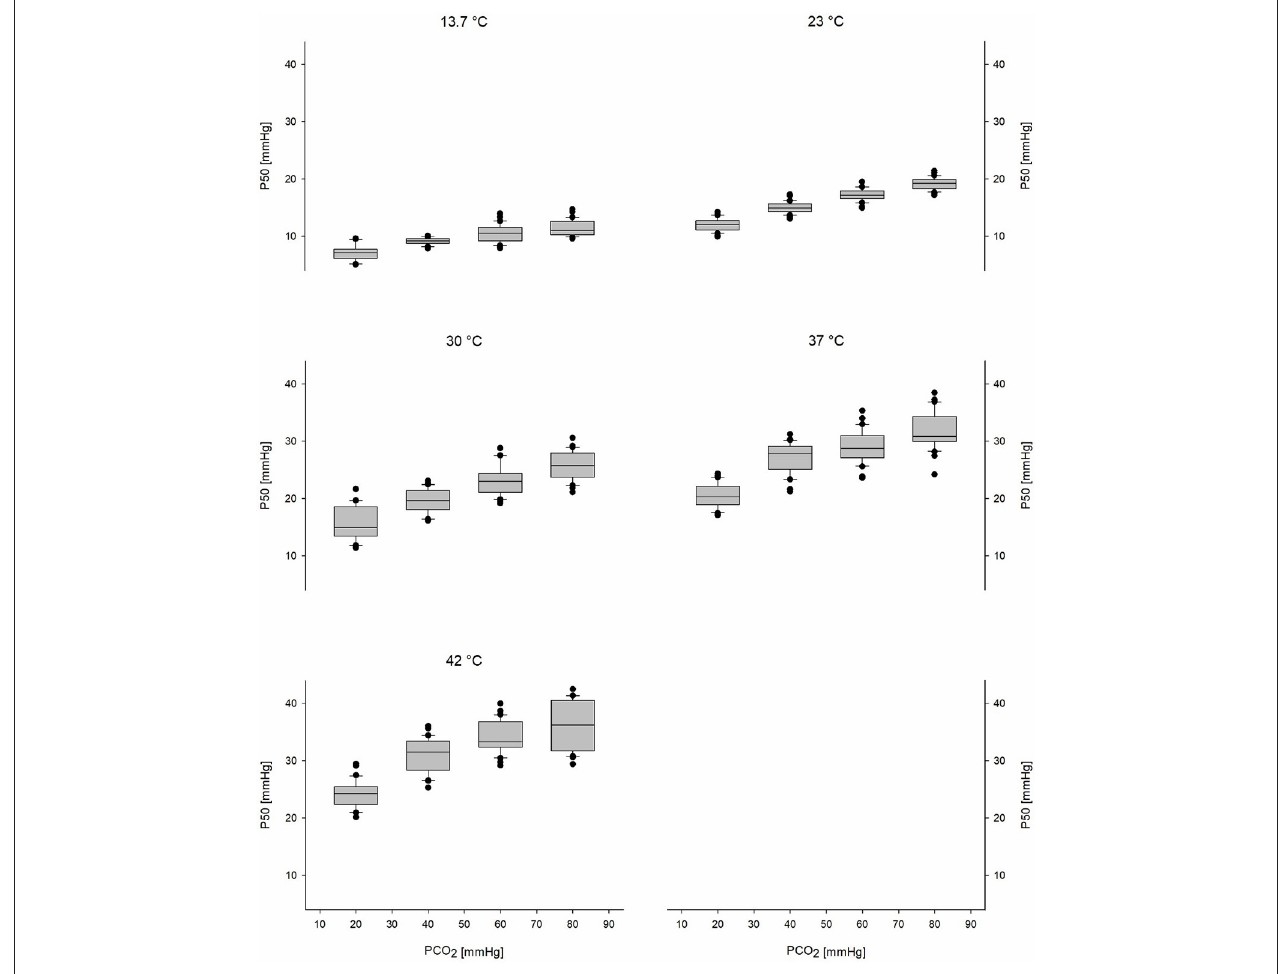
FIGURE 3 | Boxplots of the P50s of all participants show the CO 2 -Bohr effect for each temperature level. Black circles represent outliers. P50, oxygen partial pressure at which 50% of hemoglobin is saturated with oxygen; PCO 2 , carbon dioxide partial pressure.